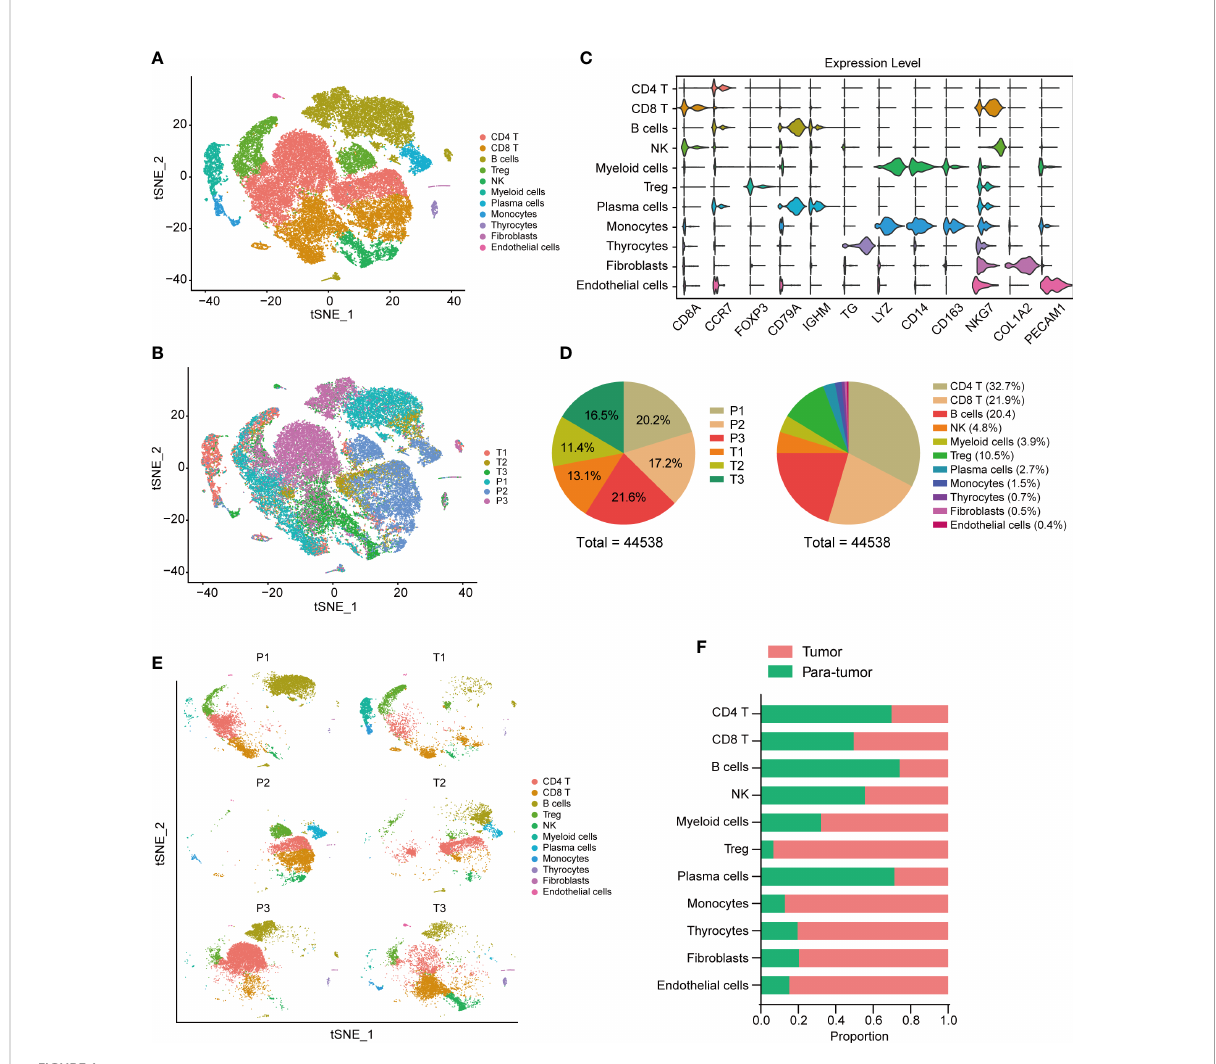
FIGURE 1 Tumor environment in thyroid cancer. t-SNE visualization of tumor ecosystem in thyroid cancer. Colored by cell clusters (A) and sample tissues (B) . (C) Violin plots of cell markers in 11 clusters. (D Cell proportions in each sample and cell cluster. (E) t-SNE visualization of cell clusters in each sample. (F) Proportions of different cell clusters in tumor and para-tumor thyroid